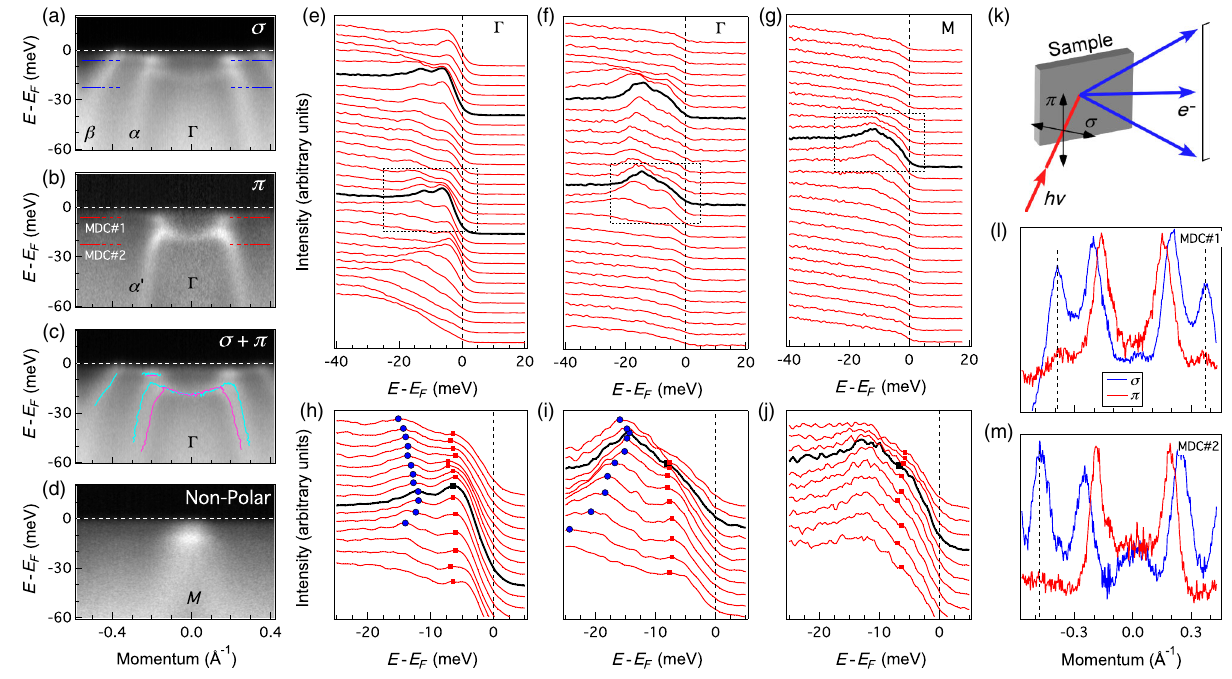
FIG. 1. (a),(b) ARPES intensity plots for a cut passing through Γ and oriented along Γ - M , recorded at 1 K, using σ and π incident-light polarizations, respectively. The dashed blue and red lines indicate the positions of the MDCs in (l) and (m). (c) Sum of the ARPES intensity plots in (a) and (b). The solid turquoise and pink curves represent the band dispersions extracted from the MDCs and EDCs in (a) and (b), respectively. (d) ARPES intensity plot for a cut passing near the M point, measured at 4.2 K with unpolarized light. (e) – (g) EDC plots corresponding to the cuts shown in (a), (b), and (d), respectively. The EDCs in black correspond to the k F positions. (h) – (j) Near- E F zooms corresponding to the the dashed boxes in (e), (f), and (g), respectively. Circles and squares are used to identify the α = α 0 band and the impurity state, respectively, as obtained by the maximum positions in the EDCs. (k) Schematic representation of the polarization configurations. (l) Comparison of the MDCs recorded with σ and π polarizations at the MDC#1 position (7 meV below E F ) in (a) (blue curve) and (b) (red curve). The vertical dashed lines are guides to the eye for the peak positions. (m) Same as (l) but for the MDC#2 position (22 meV below E F